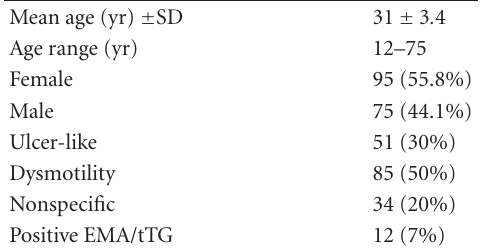
Table 2: Demographic data of patients with functional